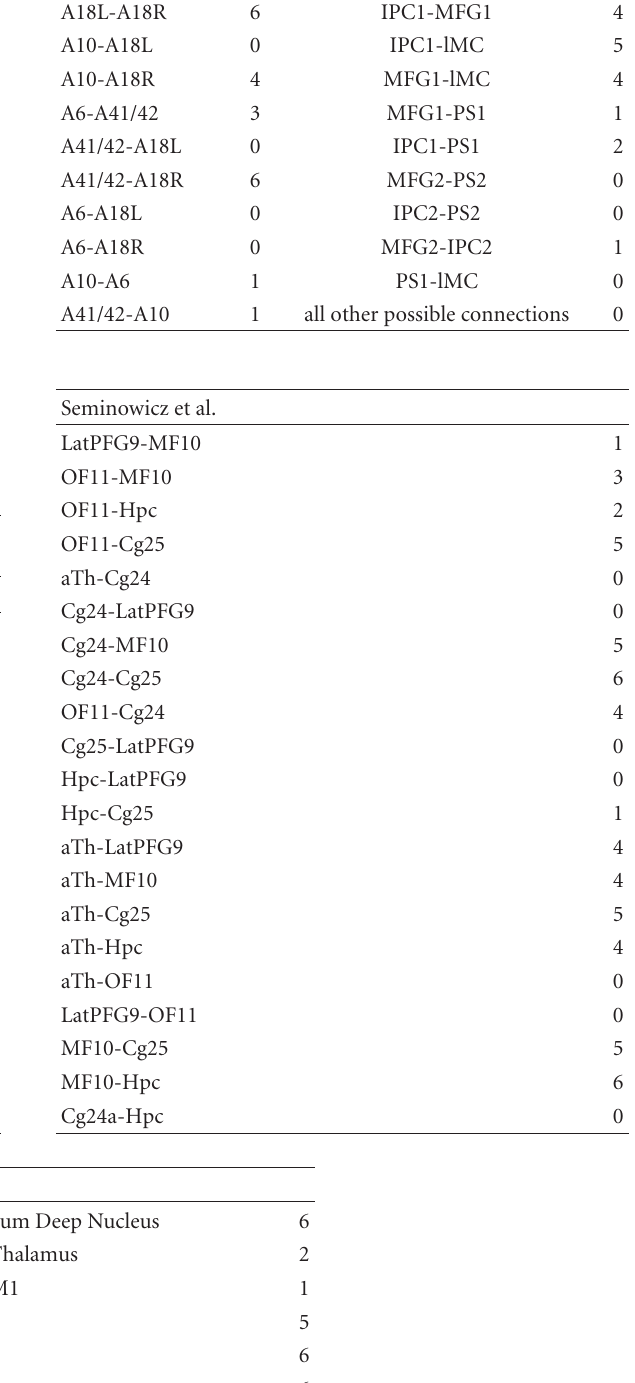
Table 1: Tractography results for all the proposed networks. The number indicates the number of subjects in which this path was found. Results in black indicate proposed paths, while results in red indicate paths that were not proposed in the original networks. B¨uchel et